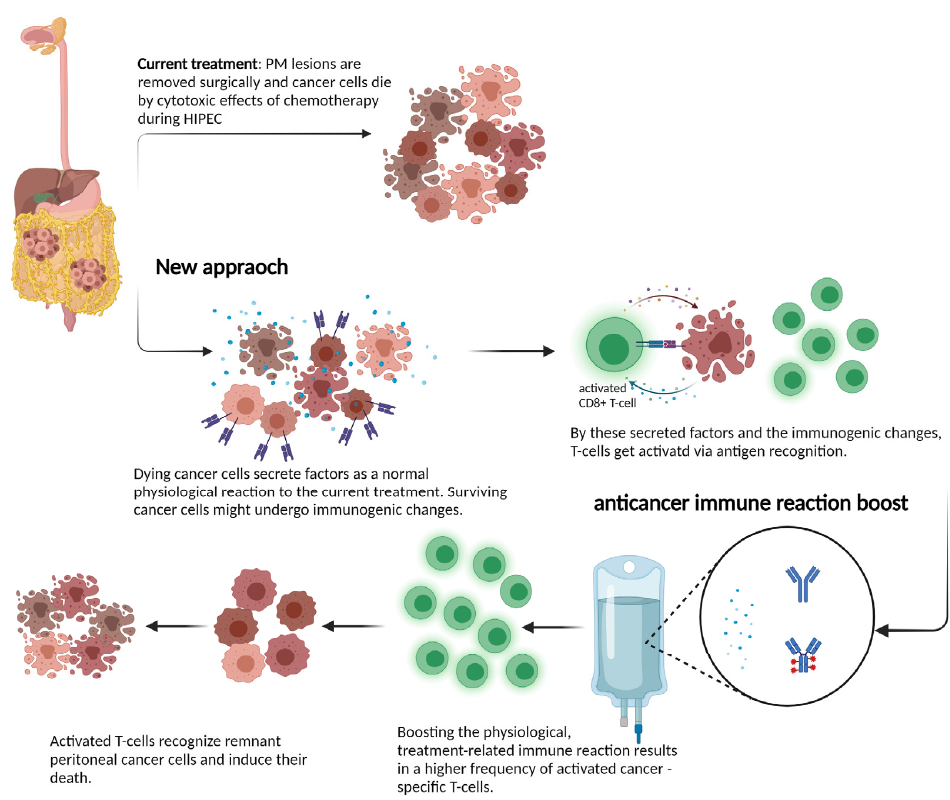
Figure 1. Schematic view of mechanisms of locoregional treatment in the peritoneum: the current interpretation of how HIPEC or PIPAC act on tumor cells is to induce cell death via direct cytotoxicity. Growing evidence on immunogenic cell death suggests that the activation of a patient’s immune system might mediate better long-term disease control through the induction of T cells. This process might be boosted in next-generation treatment approaches and induce a profound and sustained immune reaction against metastatic lesions. Created with BioRender.com.